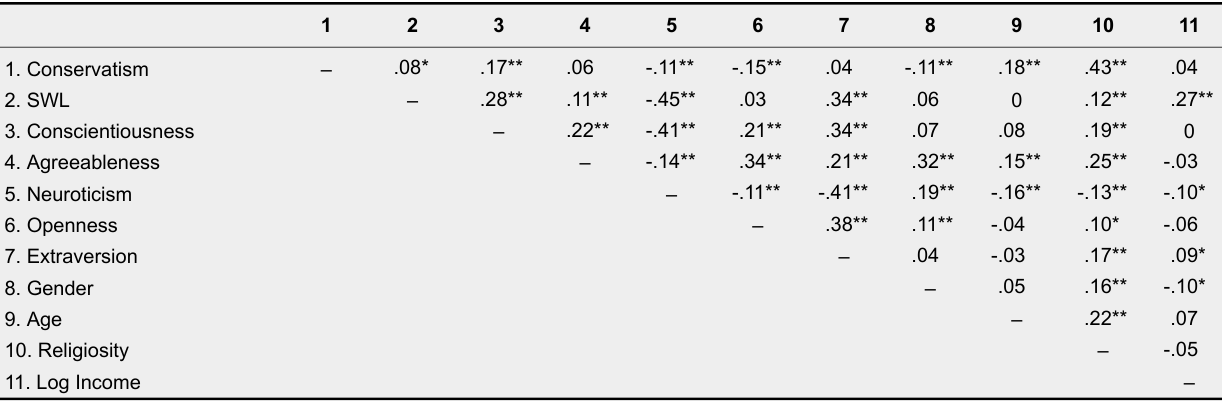
Correlation Matrix for Study 1 (N =